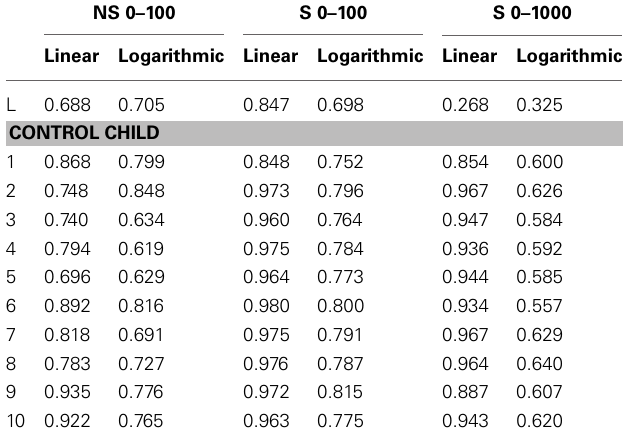
Table A4 | Overview of the individual percentages of the processing strategies in the symbolic 0–100 number line task of the child with dyscalculia and the control